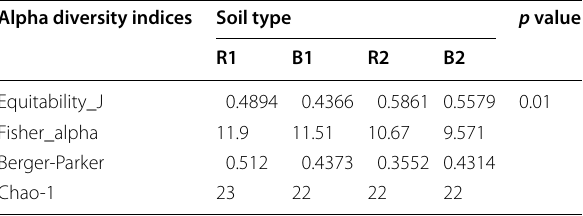
R1 Ditsobottla rhizosphere soil; B1 Ditsobottla bulk soil; R2 Kraaipan rhizosphere soil; B2 Kraaipan bulk soil; p probability value